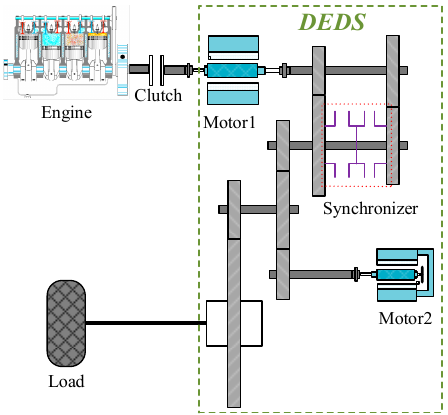
Figure 1. Schematic diagram of a torque-coupled DEDS of an HEV.